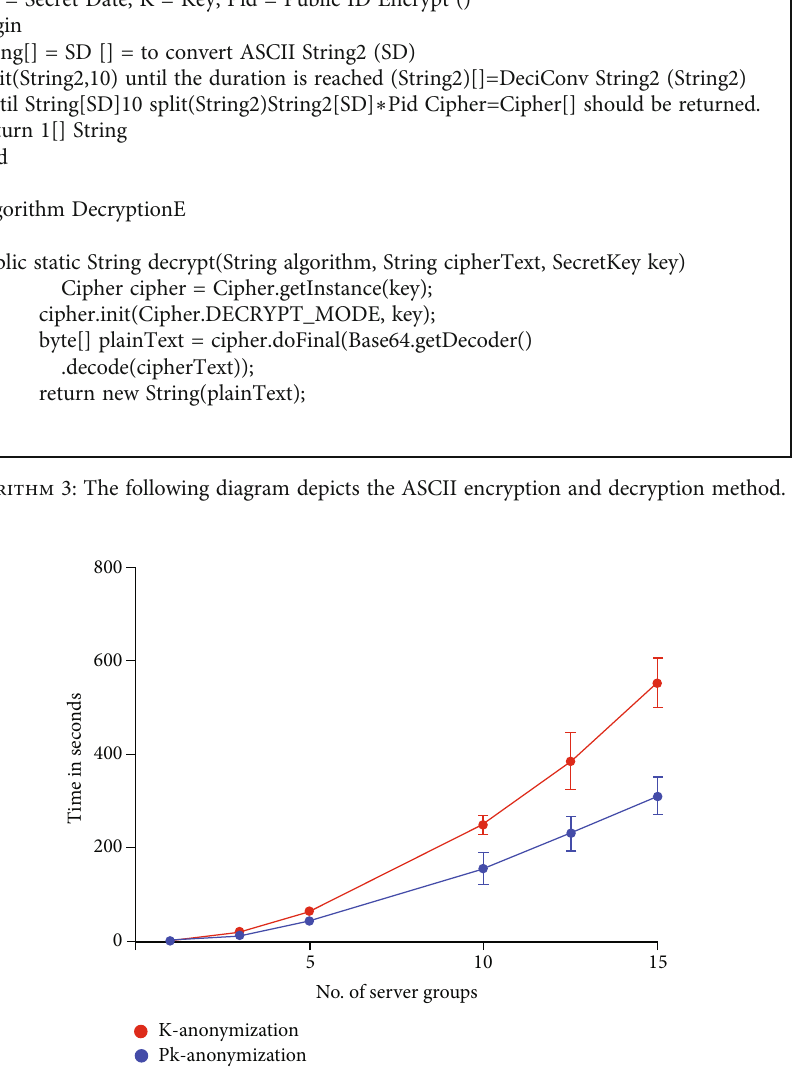
Figure 5: Di ff erence of